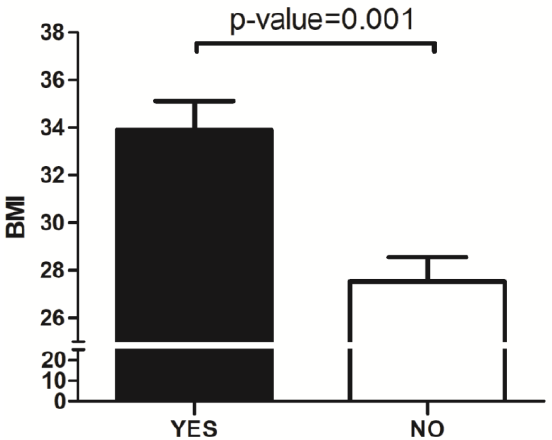
Figure 1: Inconsistent eating time and BMI mean with standard error of the Mean